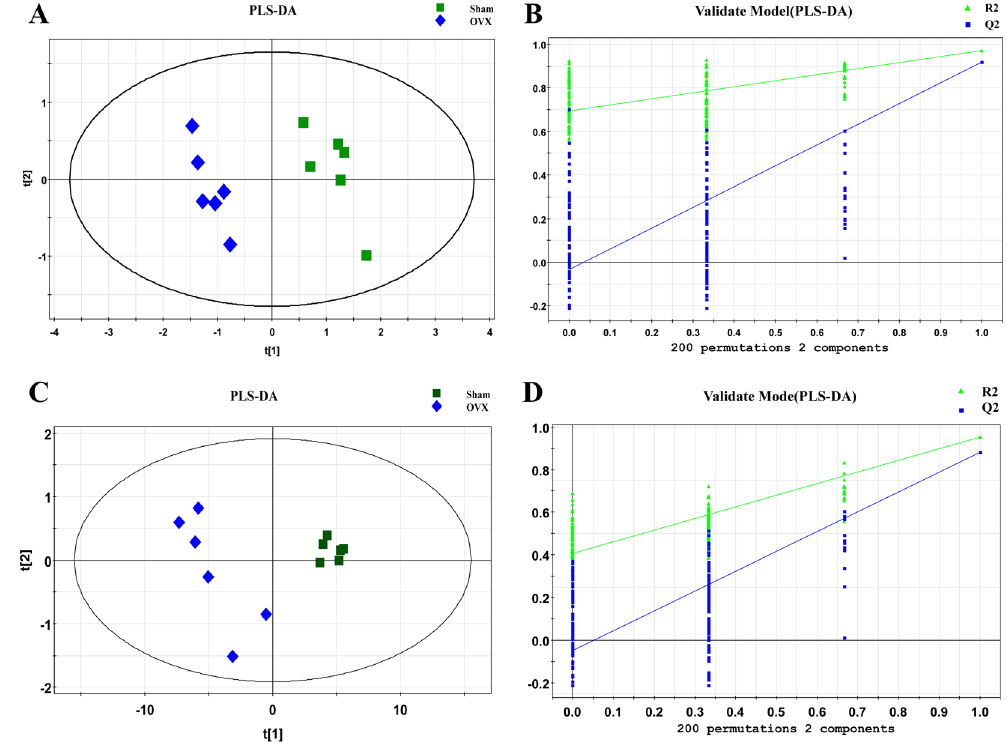
Figure 5. Plots of multivariate statistical analysis of the experimental group in ESI positive ion mode.( A , C ) PLS-DA score plot of the sham and OVX group in metabolomic and lipidomic analysis respectively; ( B , D ) Permutation test plot of the sham and OVX group in metabolomic and lipidomic analysis respectively.